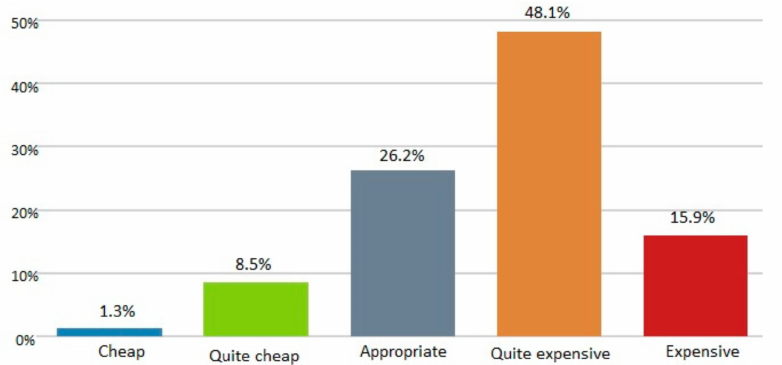
Figure A1. The price of the energy (electricity and heating) in Finland according to the respondents.